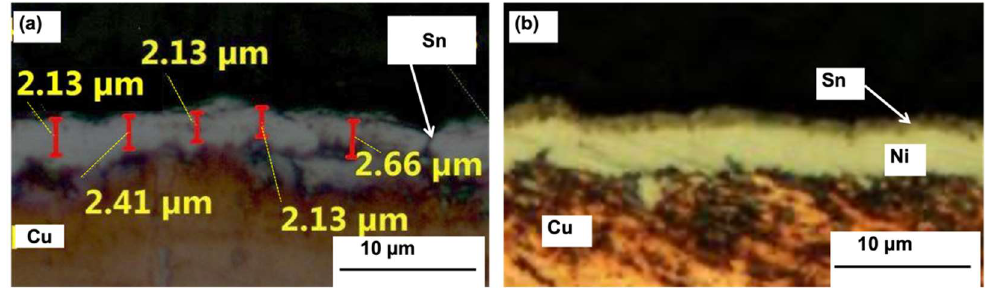
Figure 1. Cross-sectional images of ( a ) tin and ( b ) Ni underlayers deposited on copper substrate.